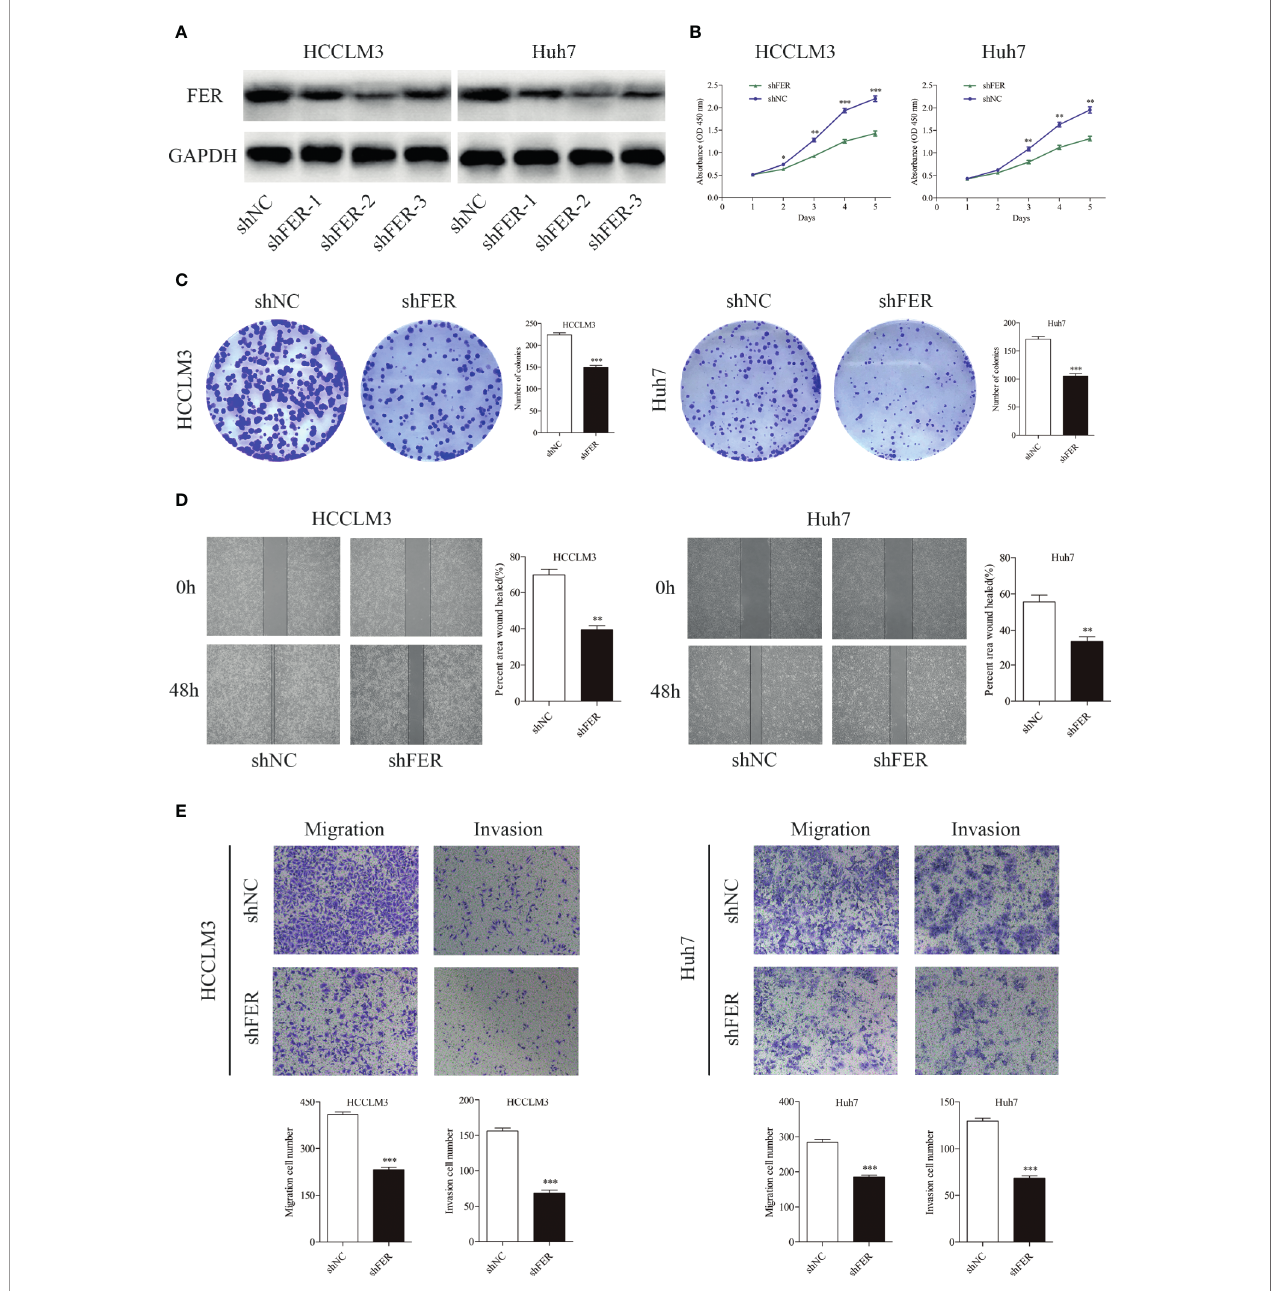
FIGURE 2 | Downregulation of FER attenuates the proliferative and metastatic abilities of HCC cells in vitro . (A) The western blot results show the FER levels after lentiviral-based small hairpin RNA (shRNA) transfection. (B) Growth curves based on CCK-8 assay results of HCCLM3 and Huh7 cells with FER silencing. (C) Representative images of colony formation assay results of HCCLM3 and Huh7 cells subjected to different treatments. (D) Knockdown of FER in HCCLM3 and Huh7 cells inhibited cell motility, as assessed by wound healing assay. (E) Transwell assays showed that HCC cells transfected with shFER exhibited reduced invasion and migration abilities. (*P < 0.05, **P < 0.01, ***P <